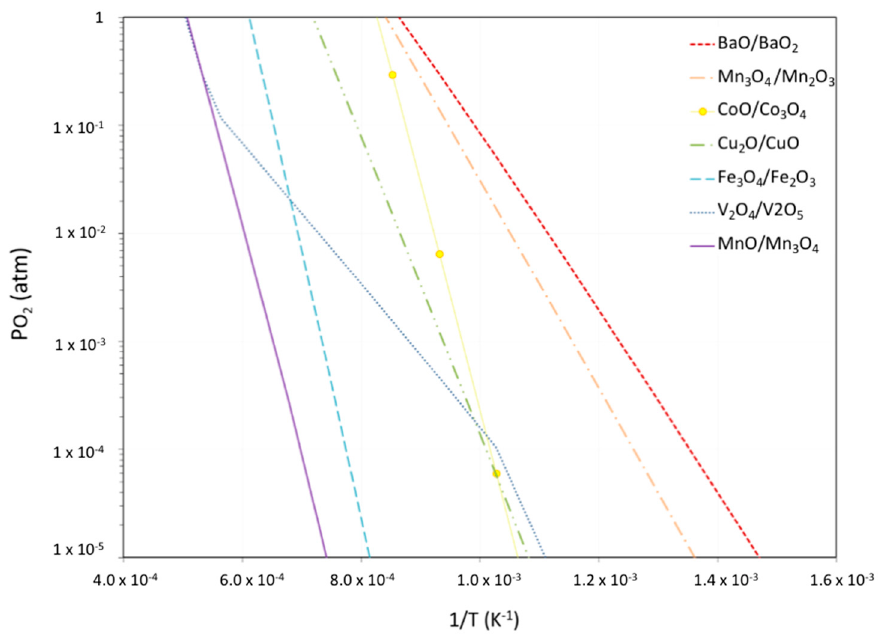
Figure 6. Transition temperature variation (1/T) as a function of pO 2 for a selection of metal oxides represented through Van’t Hoff diagram.